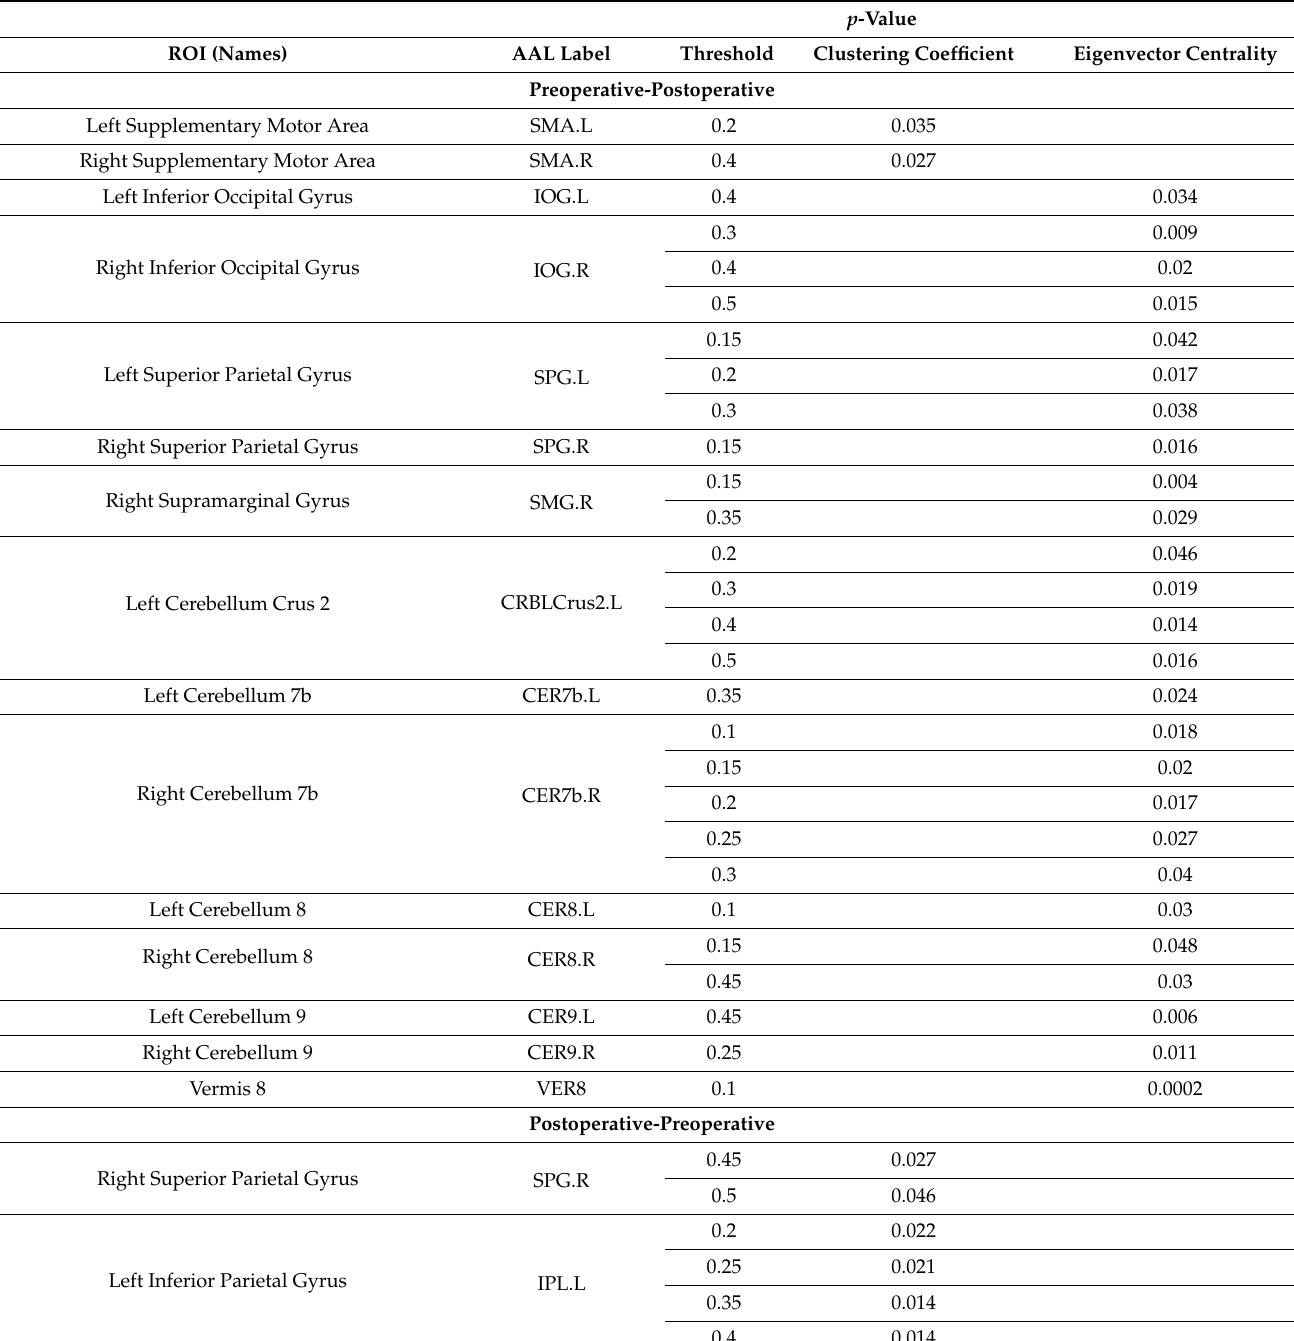
PVT results were negatively correlated with the eigenvector centrality in the right inferior occipital gyrus in two thresholds: 0.3 (r = − 0.4; p uncorrected = 0.017) and 0.4 (r = − 0.36; p uncorrected = 0.03). The strongest correlation of altered eigenvector centrality and difference in PVT is visualized in Figure 3. Table 1. List of brain ROIs with clustering coefficient and eigenvector centrality values before and after the intraocular lens implantation. p